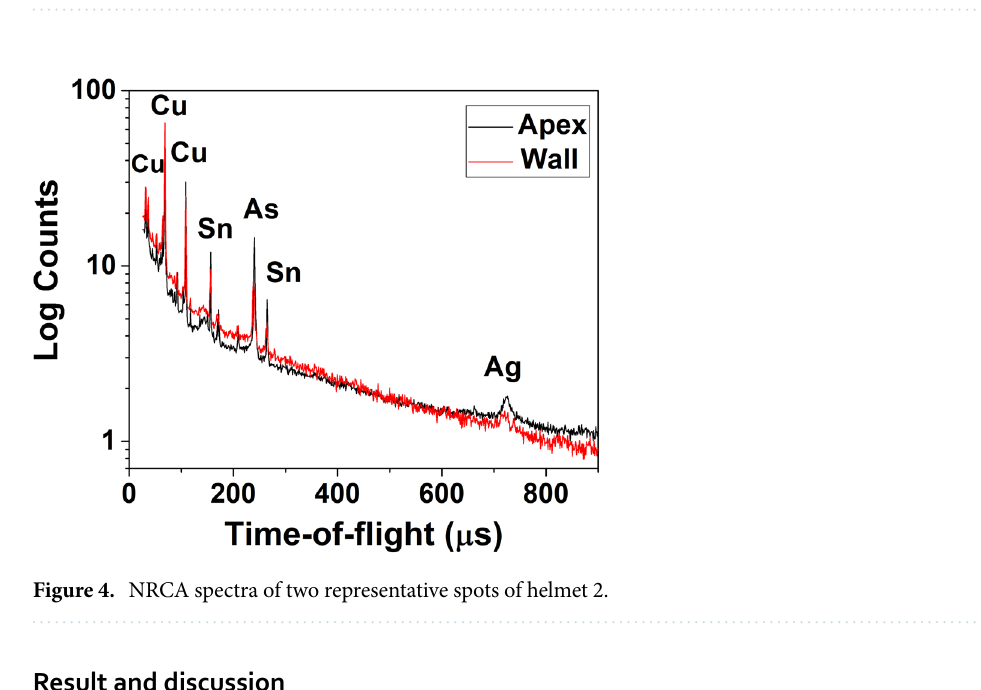
Figure 3. Two representative X-Ray fluorescence spectra of the two helmet surfaces.